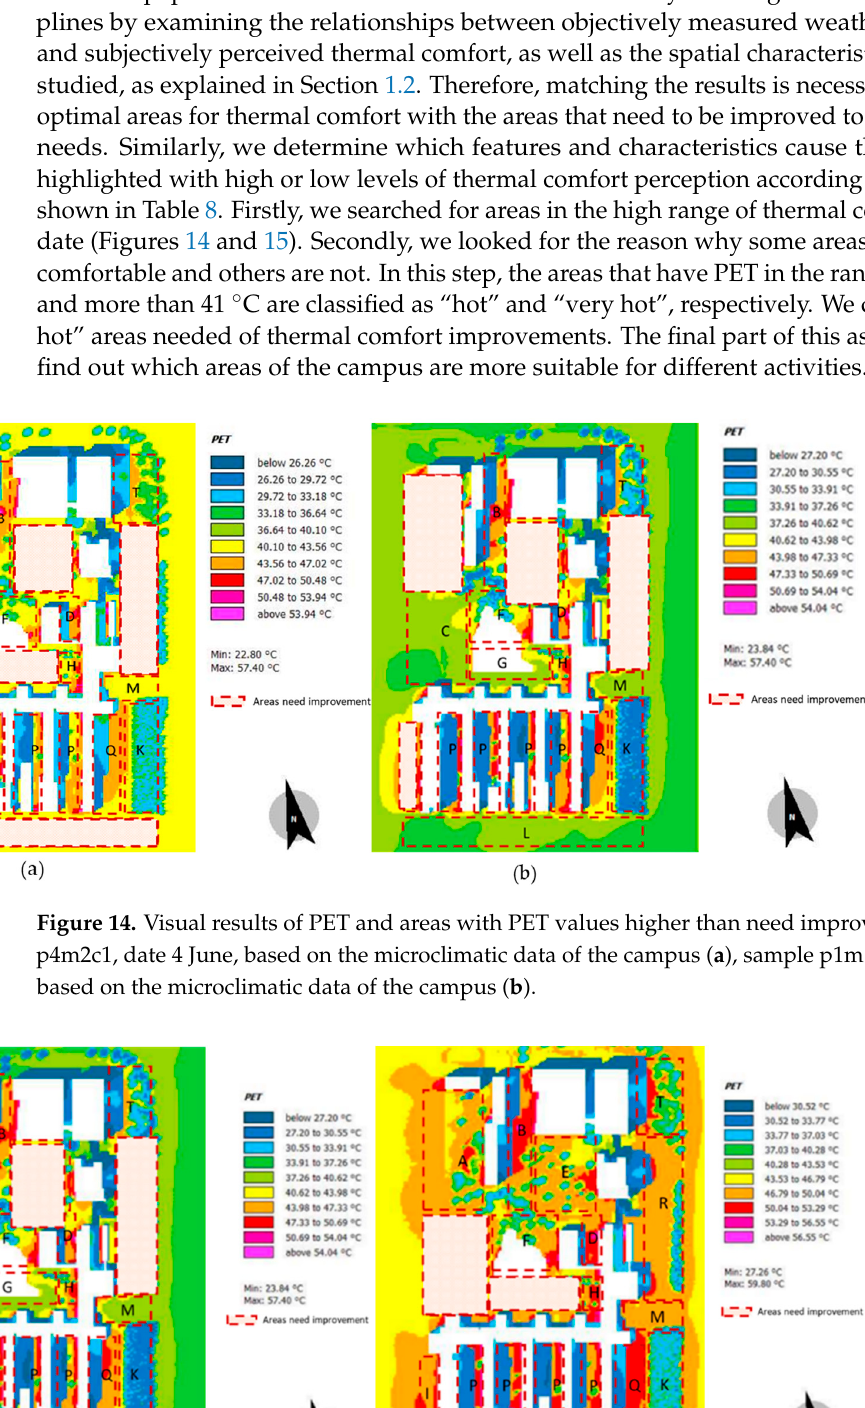
Figure 13. Visual results of PET of evaluation sample p3m2c1 on 4 June (high level of activity) ( a ), Visual results of PET of evaluation sample p4m1c2 on 4 June (low level of activity) ( b ).